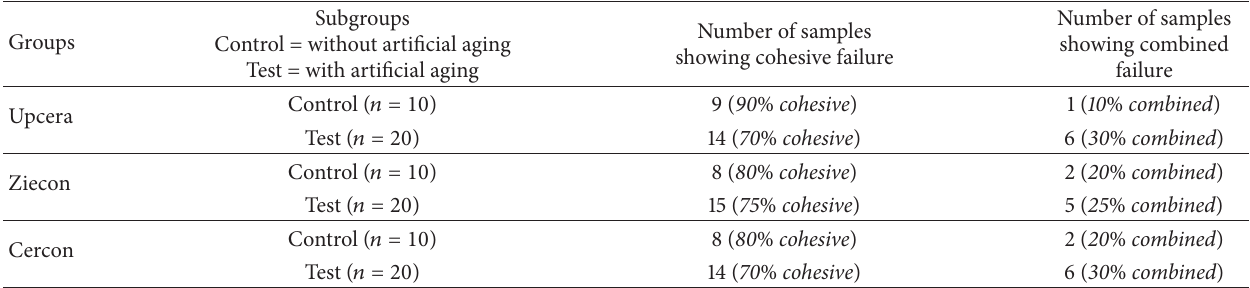
Table 6: Type of bond failures after debonding of the samples among all the three groups as examined under stereomicroscope.